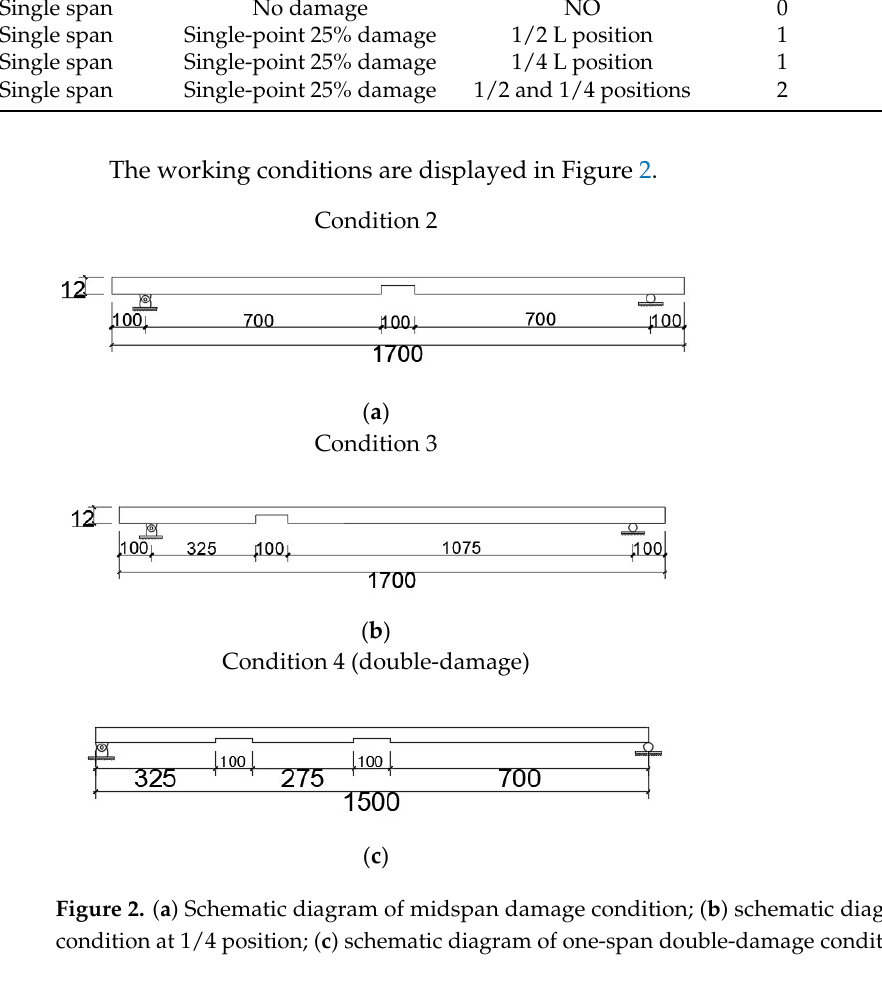
Table 2. Summary of stiffened condition.